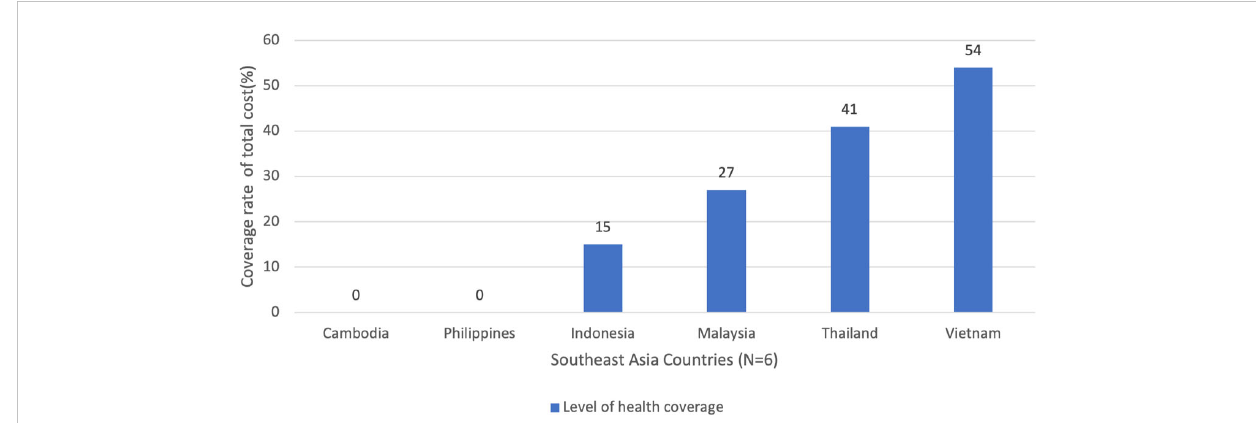
FIGURE 2 Overall universal health coverage in six Southeast Asia (SEA) countries. Notes: This data was derived from the summary of PID Life Index which demonstrated the coverage level of treatment from its total cost in each country. The coverage rate was expressed in percentage